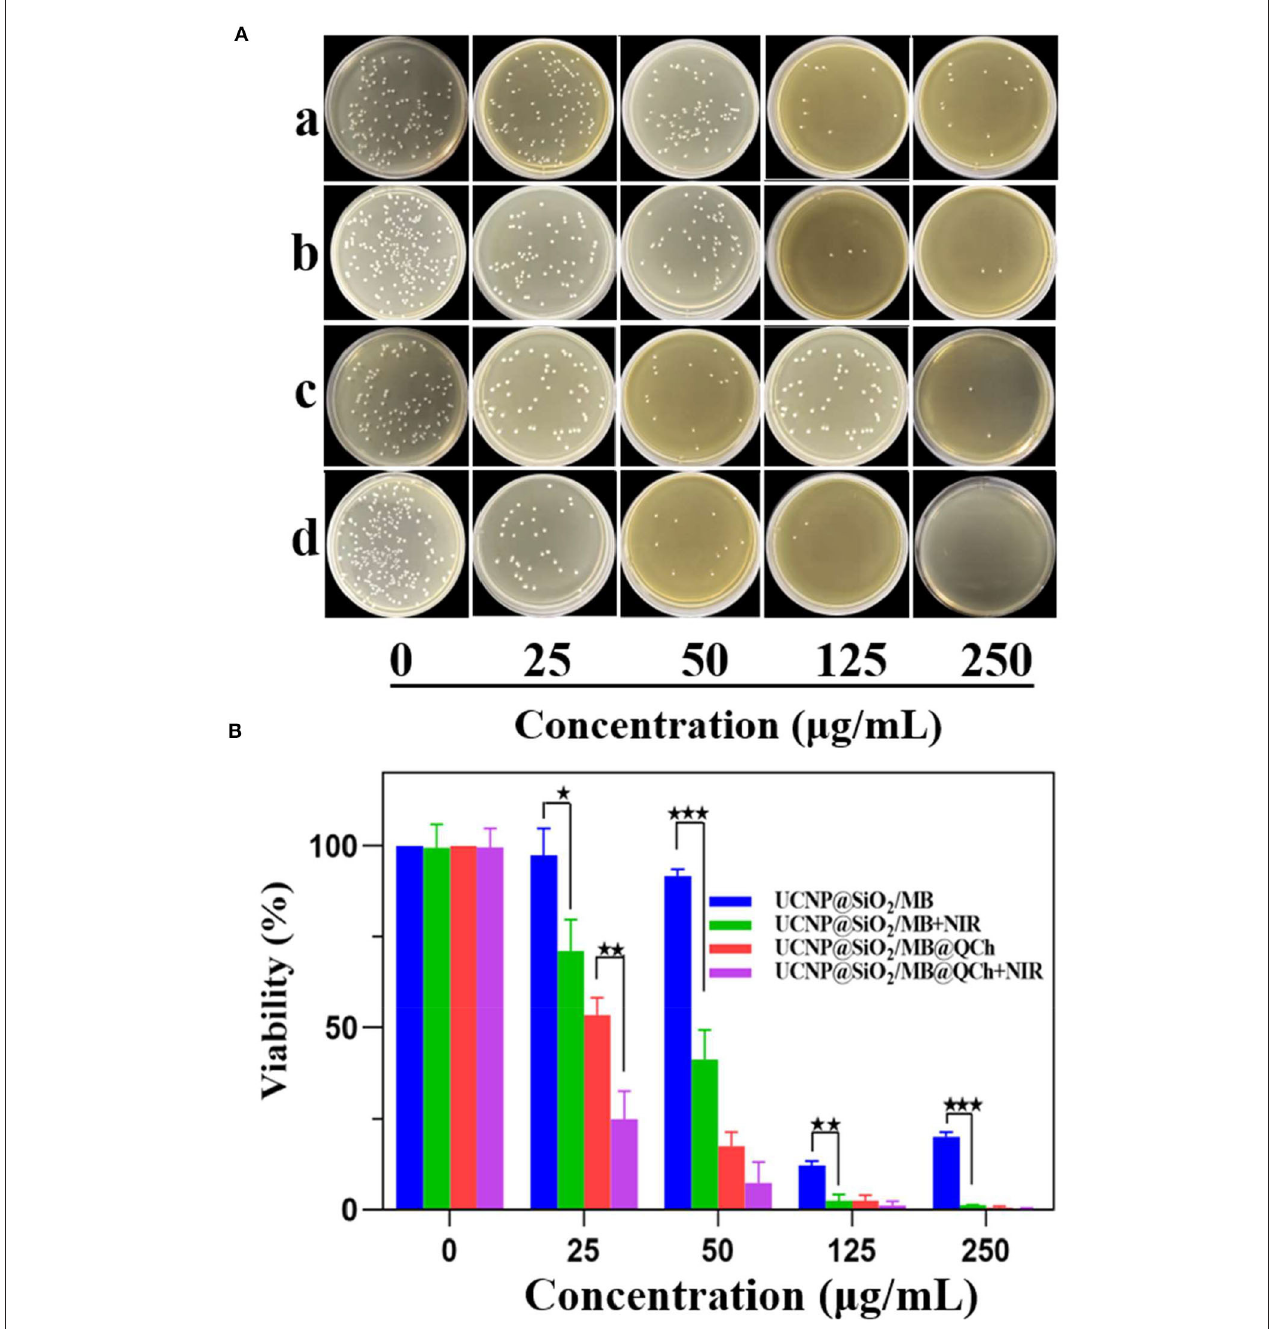
FIGURE 5 | (A) Images of residual bacterial colonies of E. faecalis on agar plates after incubation with different concentrations of UCNP@SiO 2 /MB and UCNP@SiO 2 /MB@QCh, followed by further treatment with and without NIR irradiation (980nm, 1.5W cm − 1 ). (a) means UCNP@SiO 2 /MB without NIR, (b) means UCNP@SiO 2 /MB with NIR, (c) means UCNP@SiO 2 /MB@QCh without NIR, and (d) means UCNP@SiO 2 /MB@QCh with NIR. (B) Calculated survival ratio of E. faecalis after corresponding treatments. * p < 0.05, ** p < 0.01, *** p < 0.001.